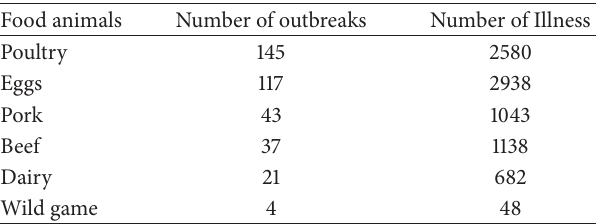
Table 3: Number of Salmonella foodborne outbreaks in the US linked to crops from 2006 to 2011